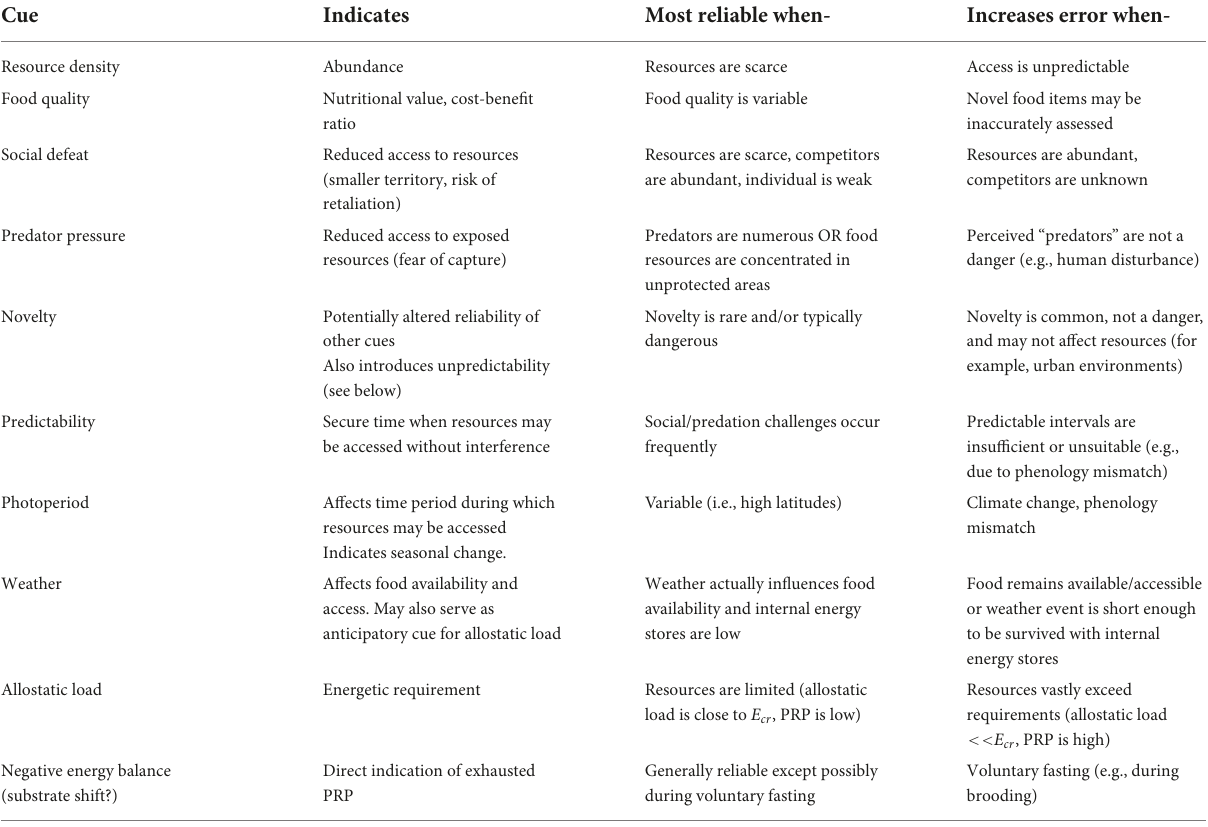
TABLE 2 Cues that may be integrated to decide whether to respond by elevating glucocorticoid